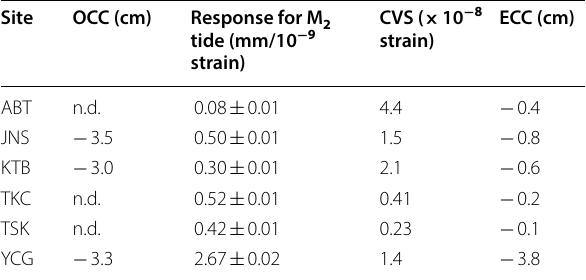
Table 3 Observed coseismic change (OCC) of groundwater level, groundwater response to the M volumetric strain (CVS) calculated using the code of Okada (1992), and expected coseismic change (ECC) in groundwater